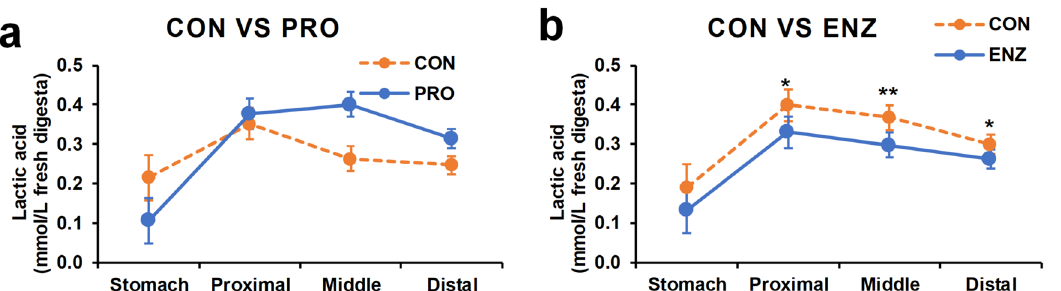
Figure 2. The lactic acid concentration in fresh chyme along the gastrointestinal tract of Nile tilapia. ( a ) The main effect of probiotics supplementation on the lactic acid concentration. ( b ) The main effect of enzyme supplementation on the lactic acid concentration. Error bars indicate standard error of means; * P < 0.05; ** P < 0.01. CON-PRO, probiotics added; ENZ-CON, enzymes added; ENZ-PRO, enzymes and probiotics